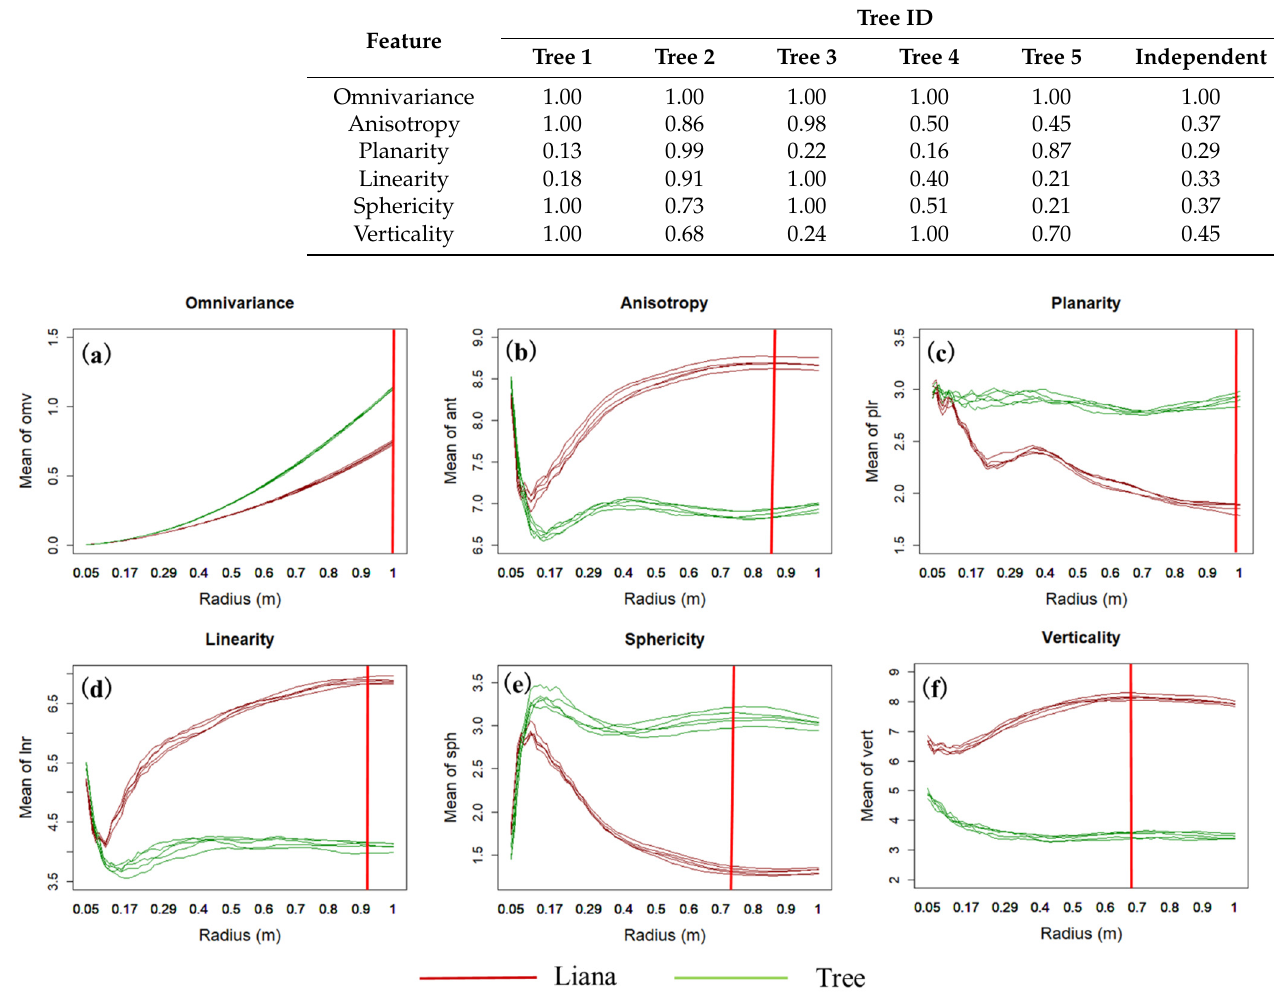
Table 3. Optimum radius for different features on the evaluated point clouds for Tree 2.